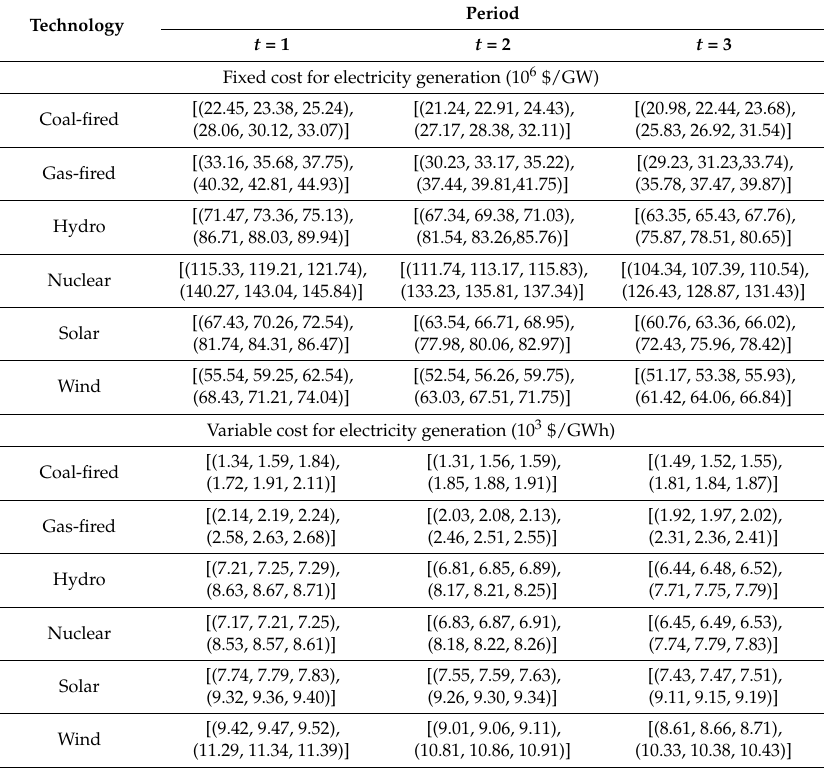
Table 1. Costs for electricity generation.